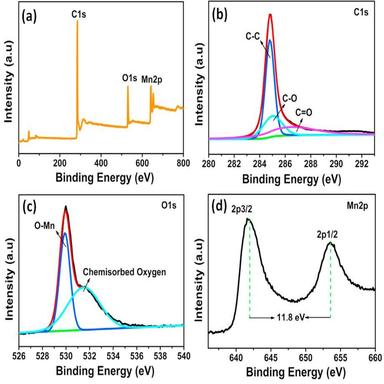
XPS spectra of (a) survey spectrum, (b) C1s, (c) O1s and (d) Mn2p.